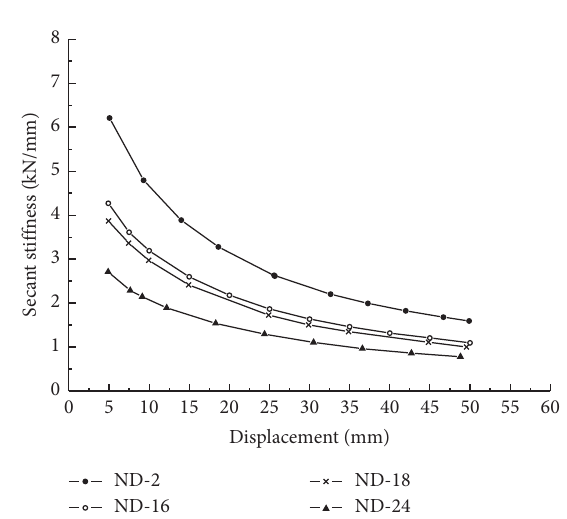
Figure 14: Stiffness curves of different slit